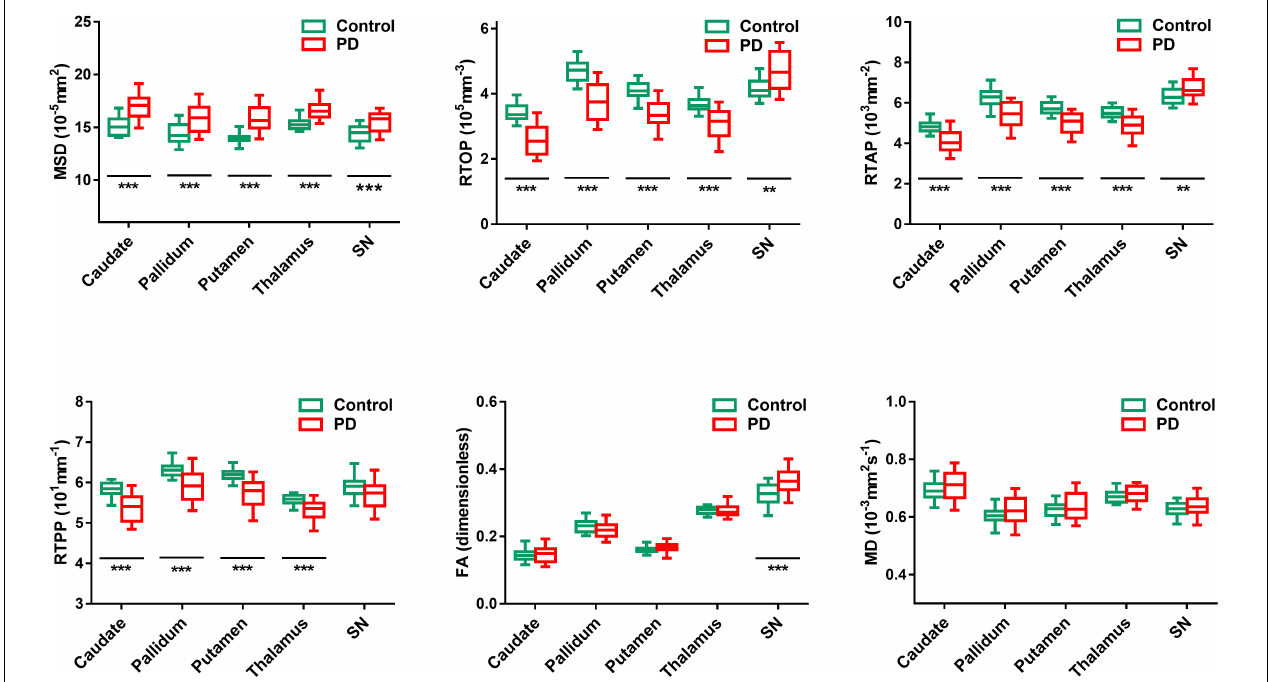
FIGURE 4 | Comparison of MAP MRI (MSD, RTOP, RTAP, and RTPP) and DTI (FA and MD) values between PD patients (red) and healthy controls (green) in the bilateral subcortical gray matter. Significant differences between PD patients and controls are represented as: * p FDR < 0.05, ** p FDR < 0.01, *** p FDR < 0.001.